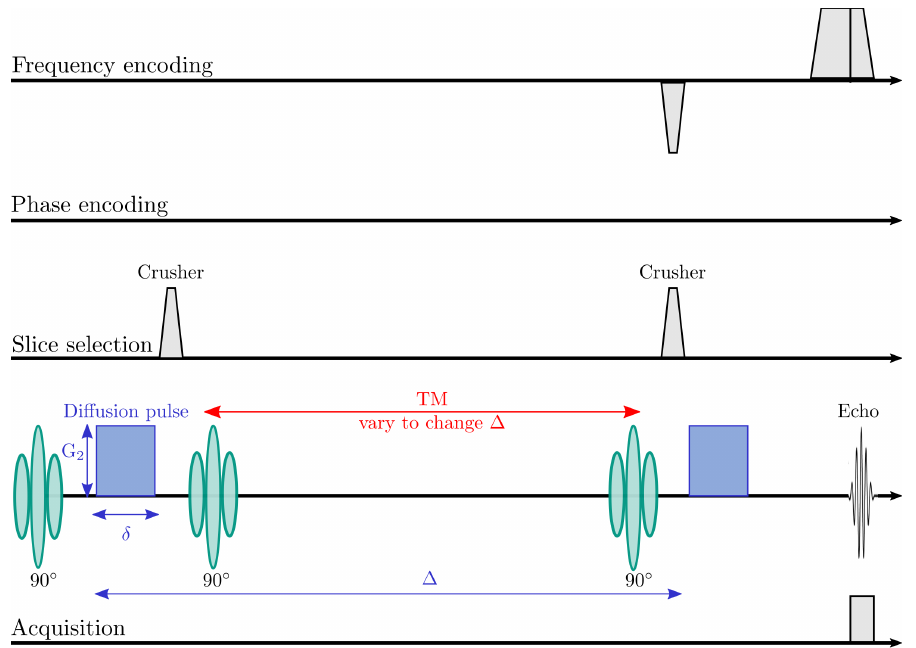
Fig 8. The 1DFT STEAM sequence: The first 90˚excitation pulse is followed by the first diffusion gradient pulse. A second 90˚pulse rotates the net magnetisation back into the longitudinal plane; there it is stored and the net phase preserved. The spins are allowed to mix before a third 90˚pulse is applied, followed by the second diffusion gradient. Δ is varied by modifying the mixing time TM between the second and third